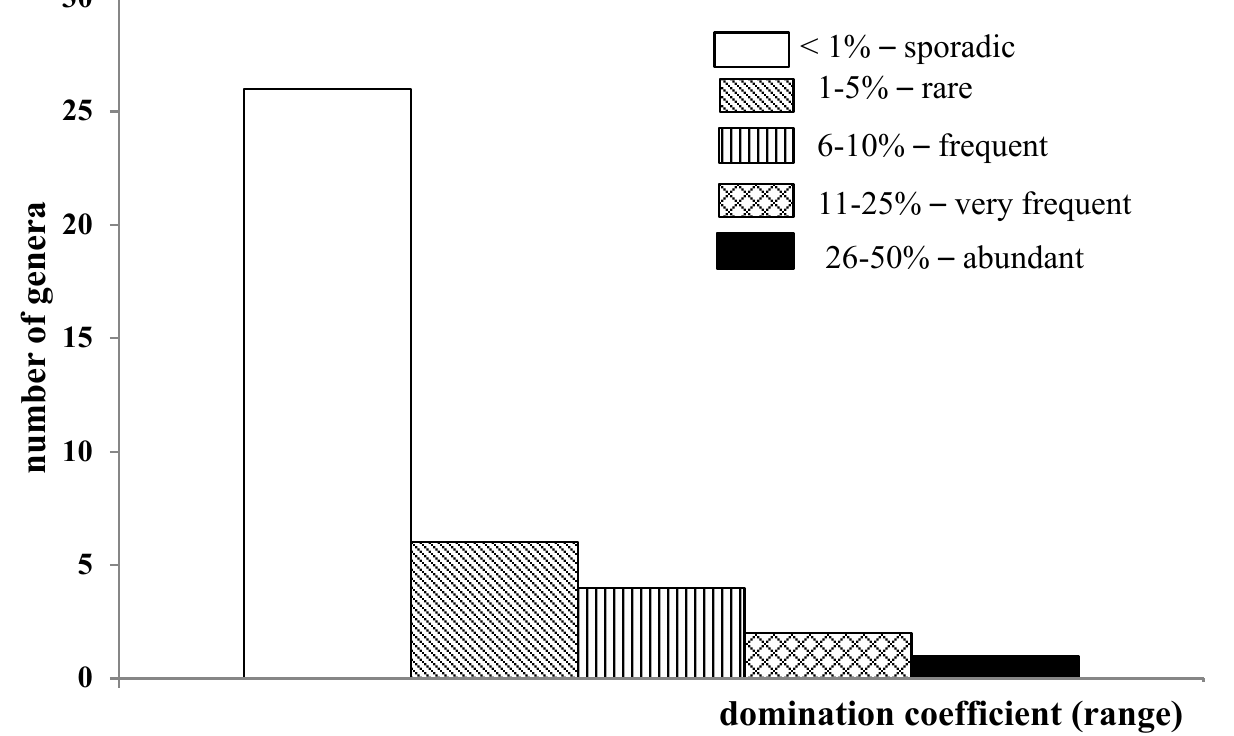
Figure 2. Frequency of genera of filamentous fungi recorded in small sewage treatment